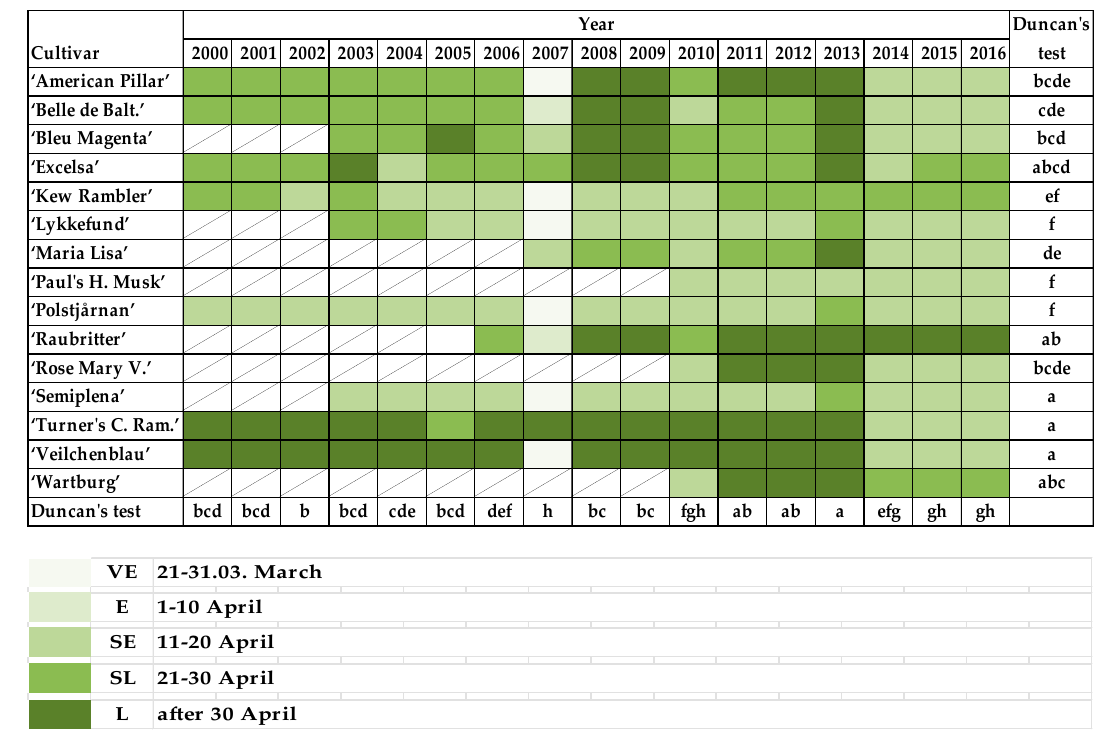
Figure 7. Periods when the first leaf pair has unfolded, not yet at full size, and leaves are light green and/or bronze on unpruned shoots (BBCH 11) of rambler roses. VE—21–31.03. March; E—1–10 April; SE—11–20 April; SL—21–30 April; and L—after 30 April. Different letters indicate significant differences between cultivars and years. The Duncan’s test ( α = 0.05) was used. Correlation analysis of the rambler roses for the timing of bud break and leaf folding showed a strict relationship with the average monthly temperature in all cultivars. The decrease of average temperature correlated with late bud break and the early leaf devel- opment stage (Tables 4 and 5 ). Table 4; Table 5 Table 4. Part of the matrices of effect correlations between average monthly air temperature (2005/2006, 2009/2010, and 2015/2016) and periods when the buds on unpruned shoots are at the beginning of breaking and the first green leaf tips are visible (BBCH 07) in rambler roses. Month Cultivar SD